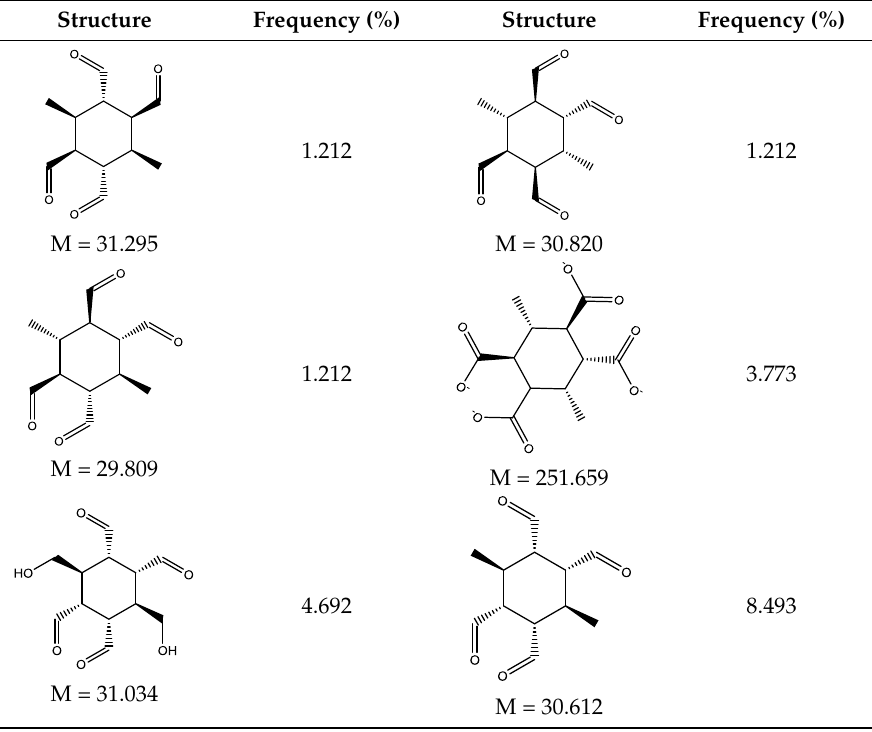
M = 31.295 M = M = 31.295 M = 31.295 M = 31.295